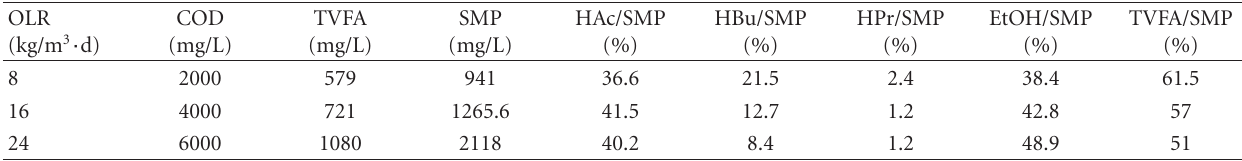
Table 3: Composition of soluble metabolites during continuous fermentation with CSTR under di ff erent OLR using molasses as the carbon source.